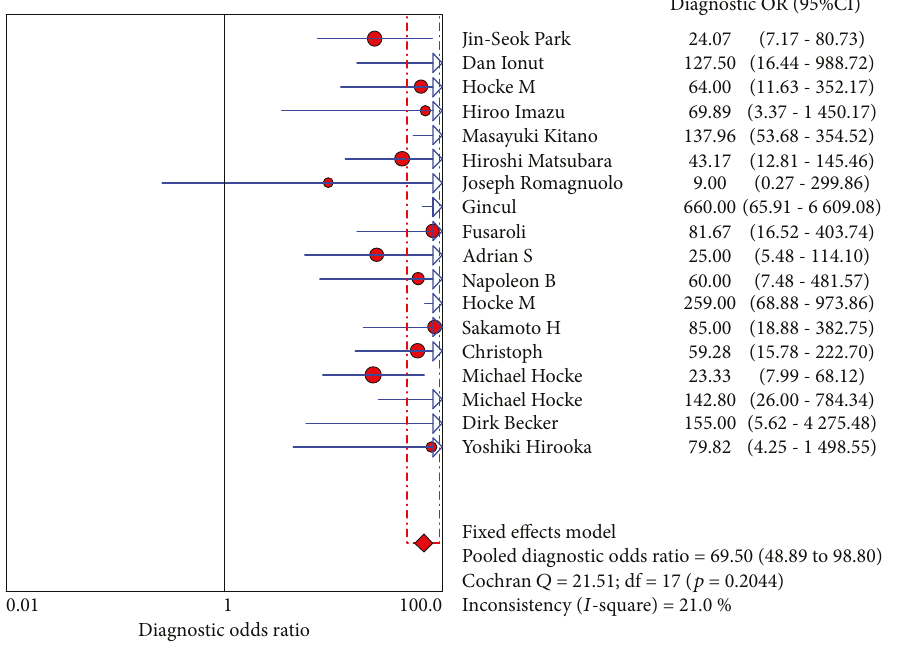
ratio0.01 100.01 Diagnostic odds Figure 7: Diagnostic odds ratio of the selected studies and this